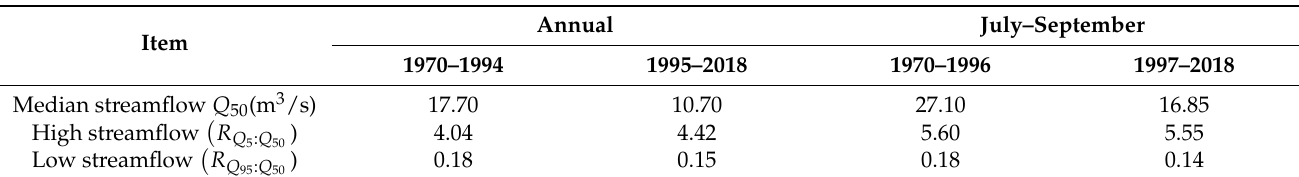
Table 4. Comparison for daily streamflow discharge characteristics before and after the abrupt point year in Beiluo River Basin.